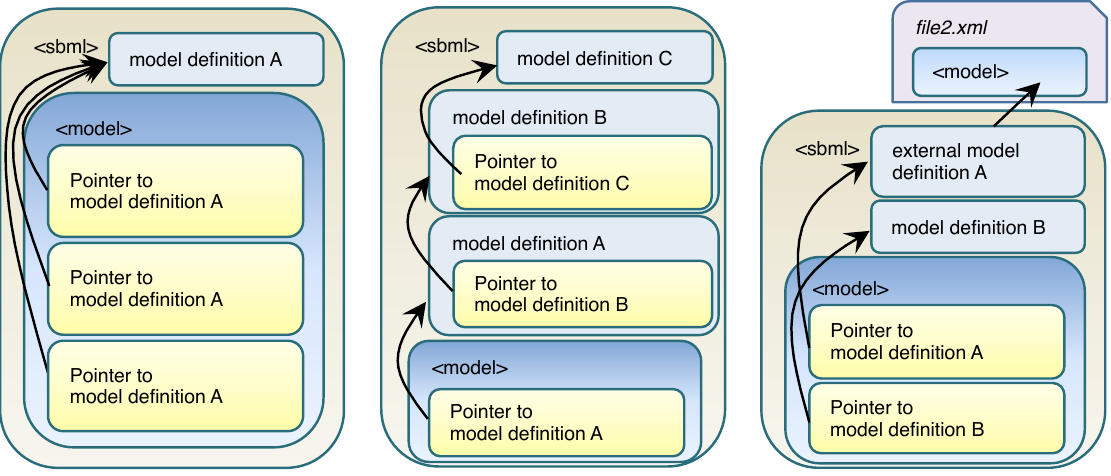
Figure 1: Three different examples of model composition scenarios. From left to right: (1) a model composed of multiple instances of a single, internally-defined submodel definition; (2) a model composed of a submodel that is itself composed of submodels; and (3) a model composed of submodels, one of which is defined in an external